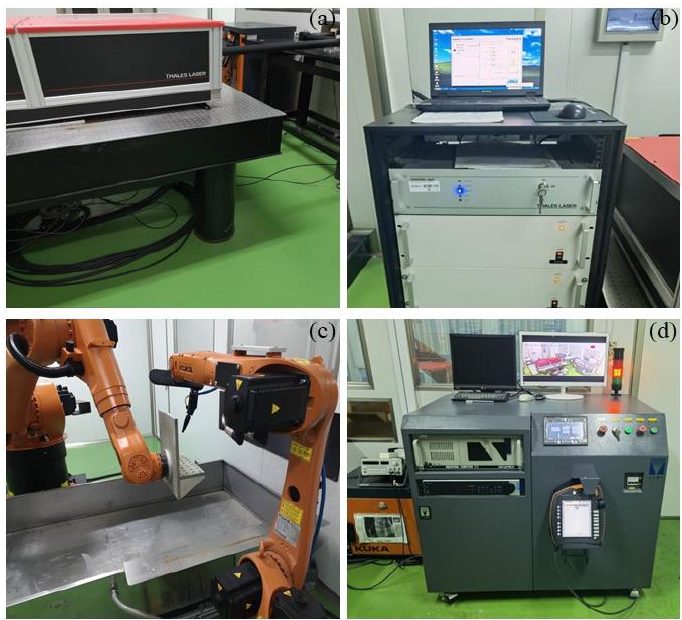
Figure 3. GAIA nanosecond pulse laser shock system: ( a ) laser system, ( b ) computer-integrated control system, ( c ) workbench and ( d ) path control system.